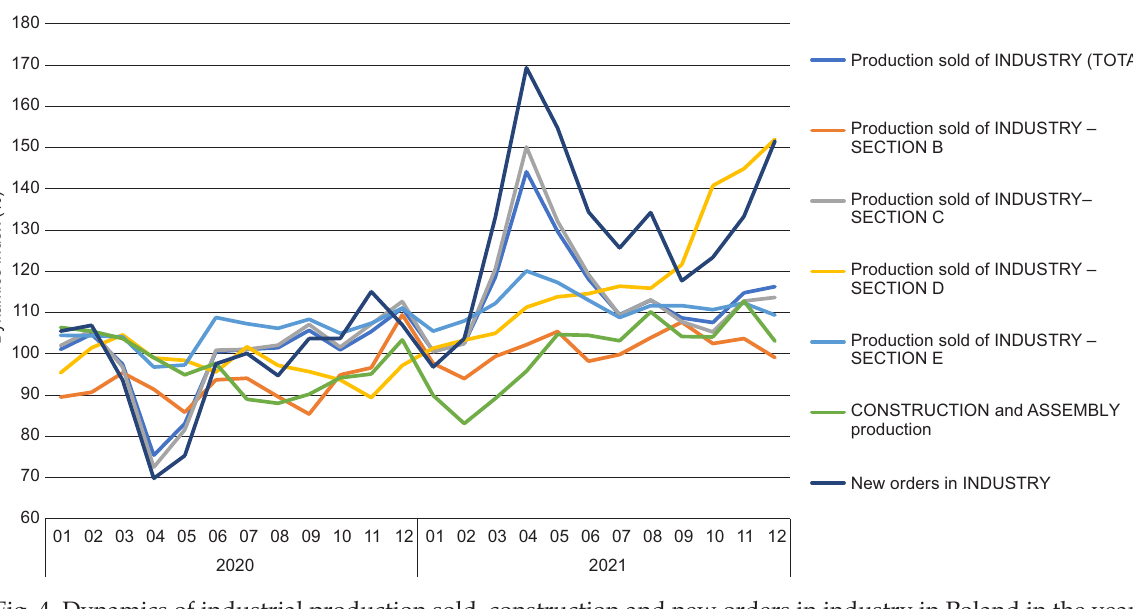
Fig. 4. Dynamics of industrial production sold, construction and new orders in industry in Poland in the years 2020–2021* (corresponding period of the previous year = 100). *Production in constant prices, new orders in current prices Section B: mining and quarrying; Section C: manufacturing; Section D: electricity, gas, steam and air conditioning supply; Section E: water supply, sewerage, waste management and remediation activities Source: own study based on Statistics Poland (GUS)